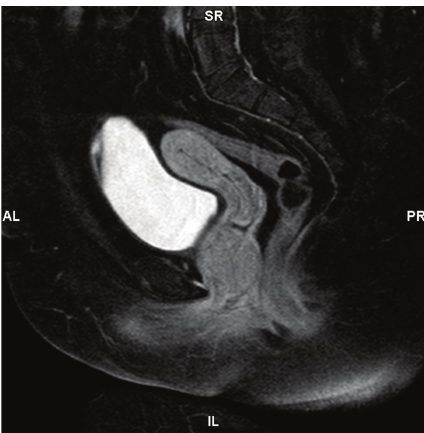
Figure 1: T2-weighted MRI of the pelvic characterized a 4 . 6 × 4 . 2 × 4 . 0 centimeter mass located within the anterior vaginal wall with mild homogeneous enhancement.